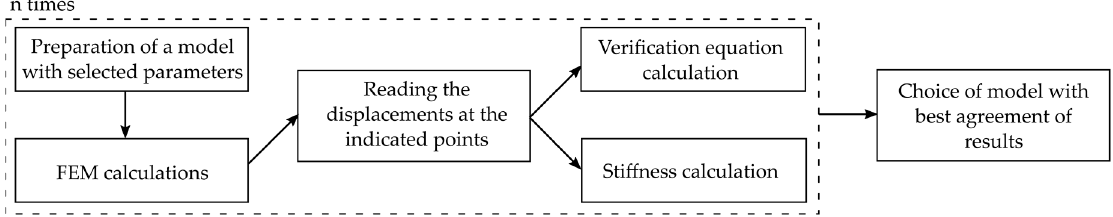
Figure 11. Flowchart of the calibration process.